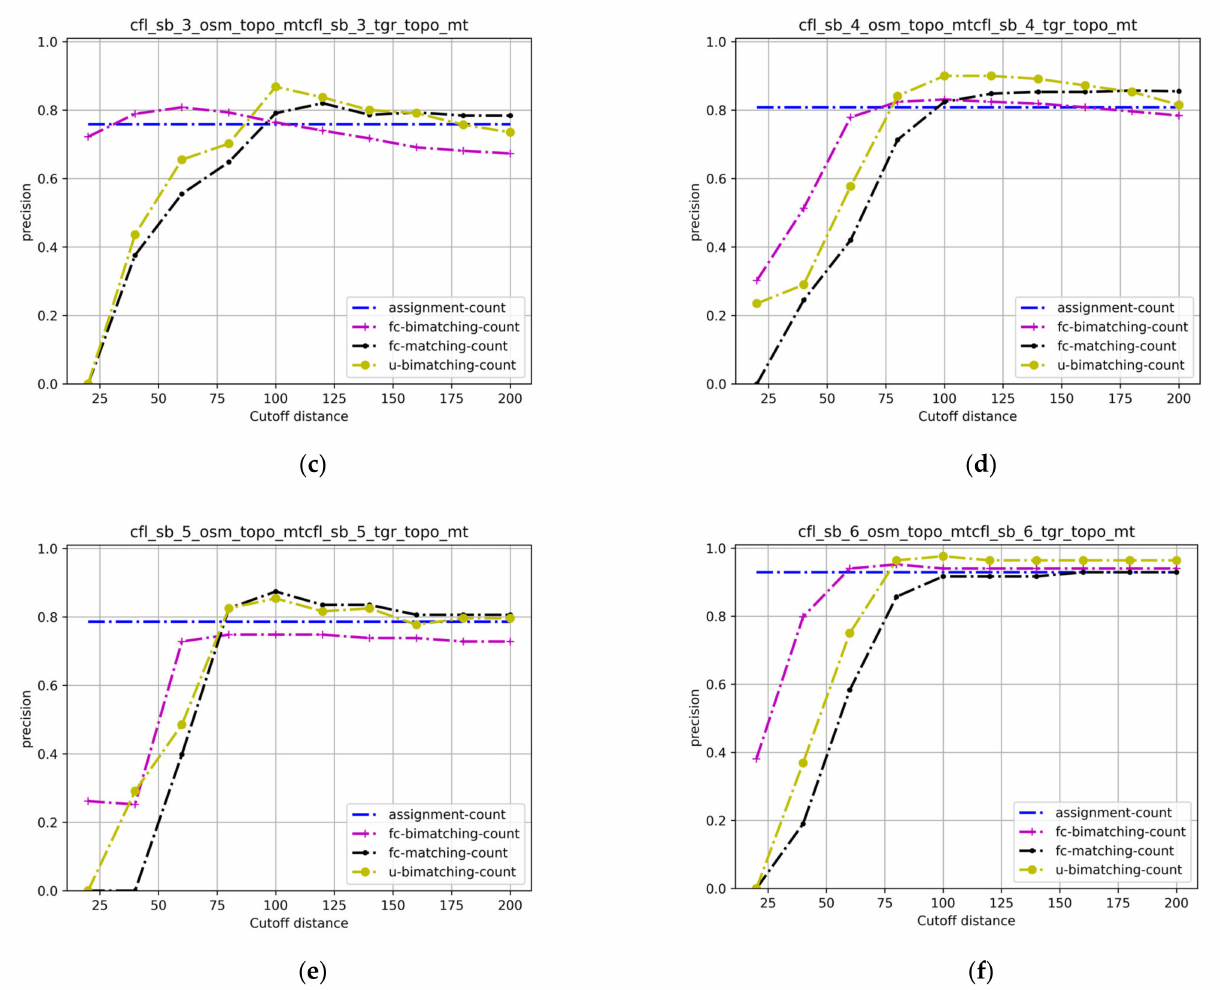
Figure 4. Precision rates of optimized conflation models for the Santa Barbara dataset (OSM vs. TIGER). ( a – f ) Results for sites #1 through